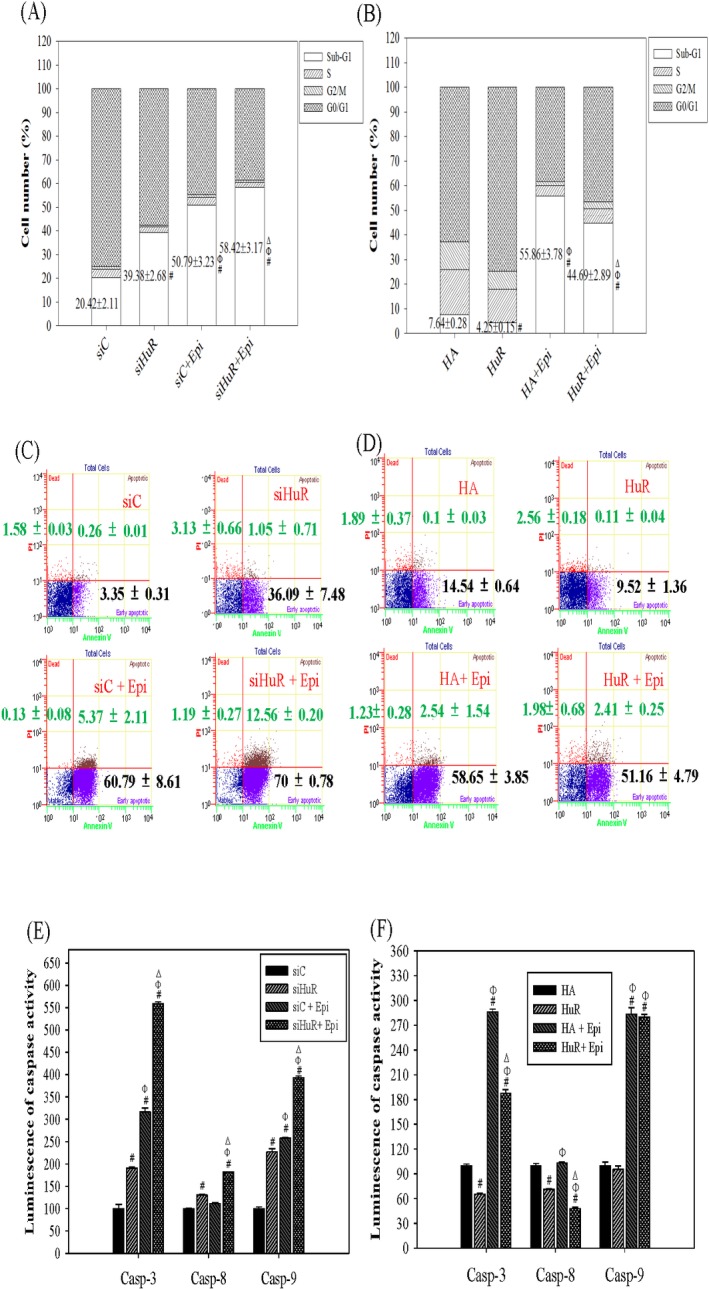
The effect of HuR knockdown and overexpression on the cell cycle and apoptosis of Epi-treated SW620 cells.Cells were transfected with 75 nM siC and siHuR (A, C, E), or with 2 μg/ml HA and HuR (B, D, F). After 24 h, cells were treated with Epi (5 μg/ml) for 24 h. Cells were then collected for the following analysis. (A, B) The effect of HuR silencing and overexpression on cell cycle distribution of Epi-treated SW620 cells. Cells were fixed and stained with PI then analyzed for cell cycle distribution by flow cytometry. The percentage of cells in each cell cycle stage was calculated and means from three independent experiments plotted. Statistical significance comparing the sub-G1 population was shown. # P<0.05 compared to the siC (A) or HA (B) group; Φ P<0.05 compared to the siHuR (A) or HuR (B) group; Δ P<0.05 compared to the siC + Epi (A) or HA + Epi (B) group. (C, D) The effect of HuR knockdown and overexpression on apoptotic population of Epi-treated SW620 cells. The apoptotic population of cells was detected by Annexin V apoptosis assay and analyzed by flow cytometry. The mean percentages of early apoptotic population (bottom right) and late apoptotic population (top right) from three independent experiments were calculated then the means ± S.D. were shown in each represented panel. (E, F) The effect of HuR silencing and overexpression on the intrinsic and extrinsic apoptosis pathway of Epi-treated SW620 cells. Cells were harvested for detection of the endogenous activity of caspase proteins by Caspase-Glo® 3/7, 8, 9 assay system and analyzed by Luminescence immunoassay analyzer. The relative percentage of caspase activity was calculated by setting the mean luminescence intensity of siC (E) or HA (F) group as 100%. Data are presented as means ± S.D. from three independent experiments. # P<0.05 compared to the siC (E) or HA (F) group; Φ P<0.05 compared to the siHuR (E) or HuR (F) group; Δ P<0.05 compared to the siC + Epi (E) or HA + Epi (F) group.